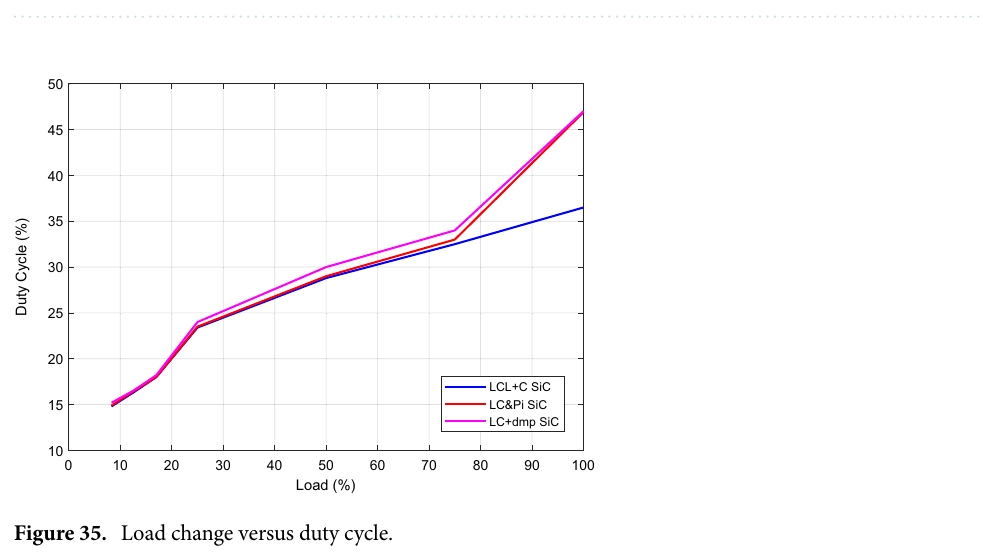
Figure 34. Step responses of isolated PFC Ćuk converter and with each DM filter structures.